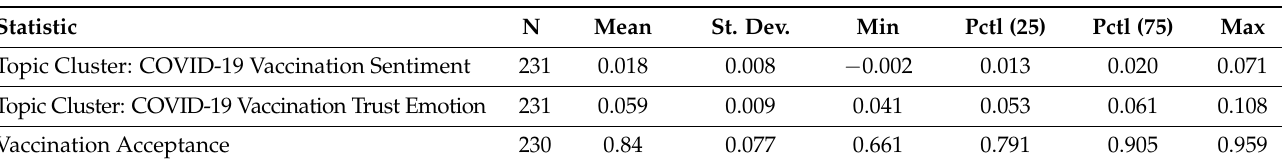
Table 2. Descriptive statistics of